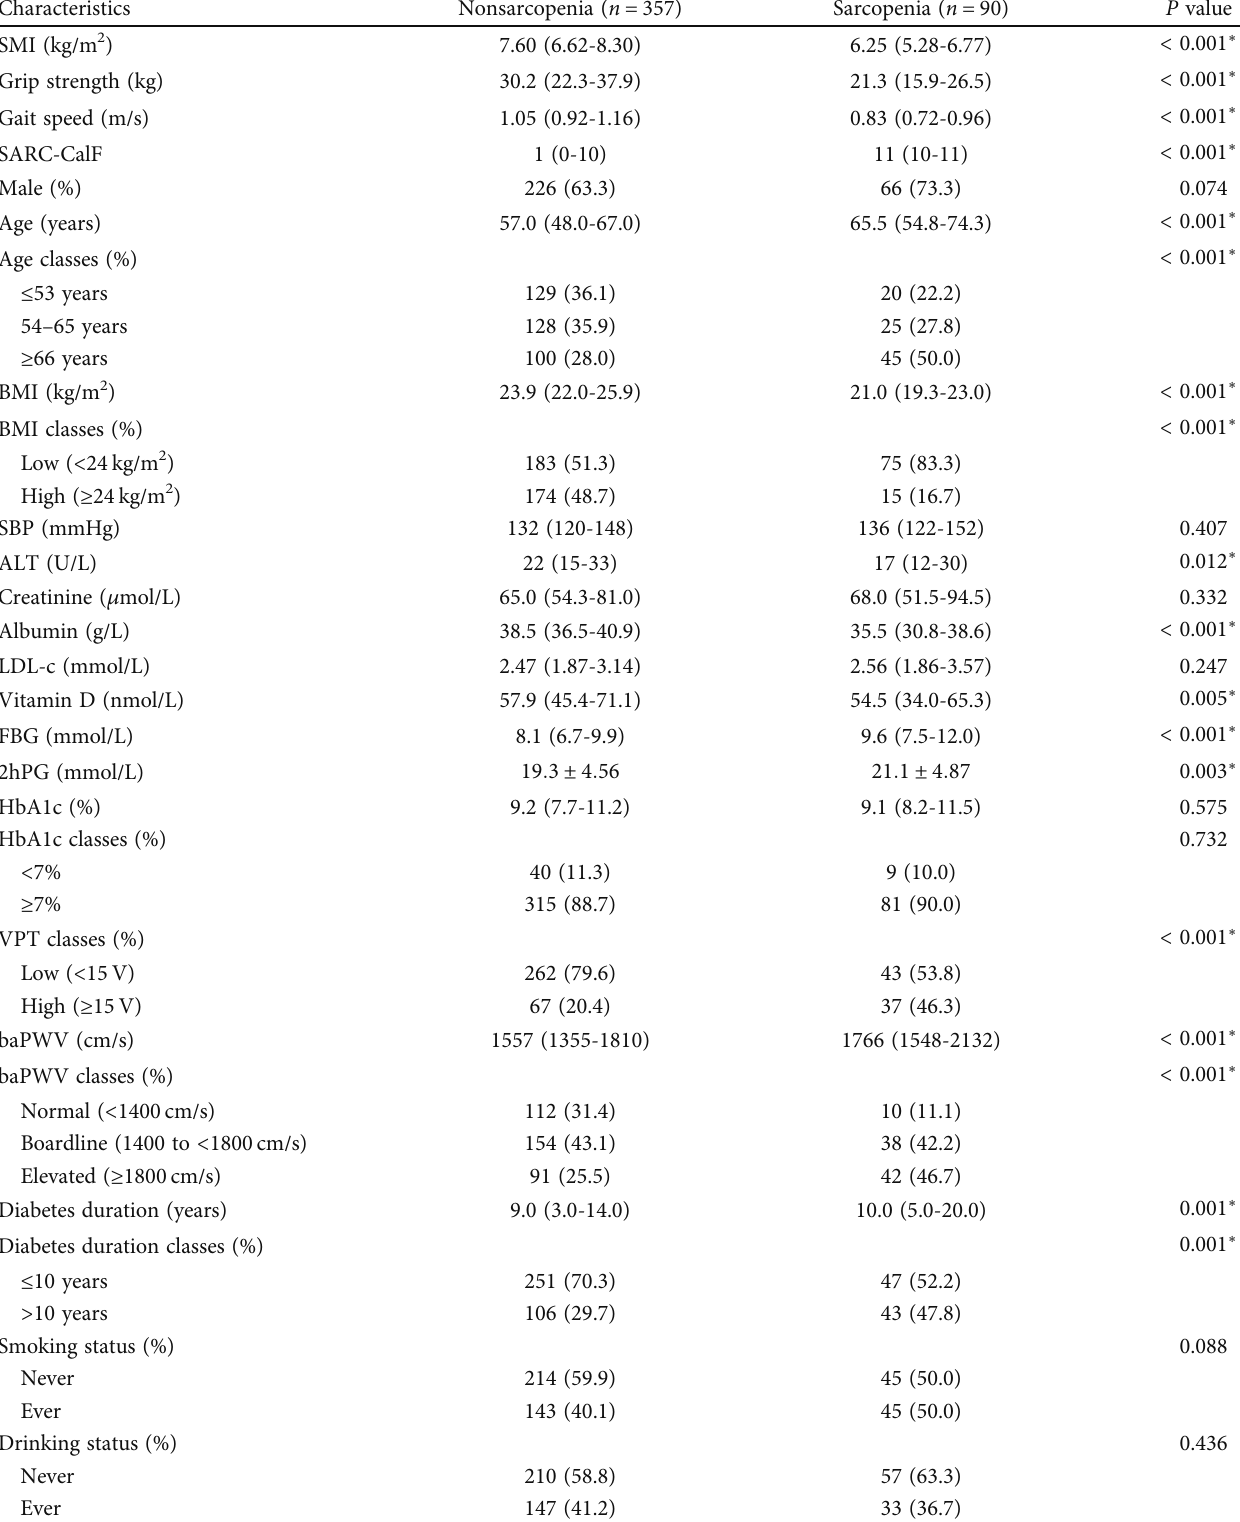
Table 1: Characteristics of patients with or without